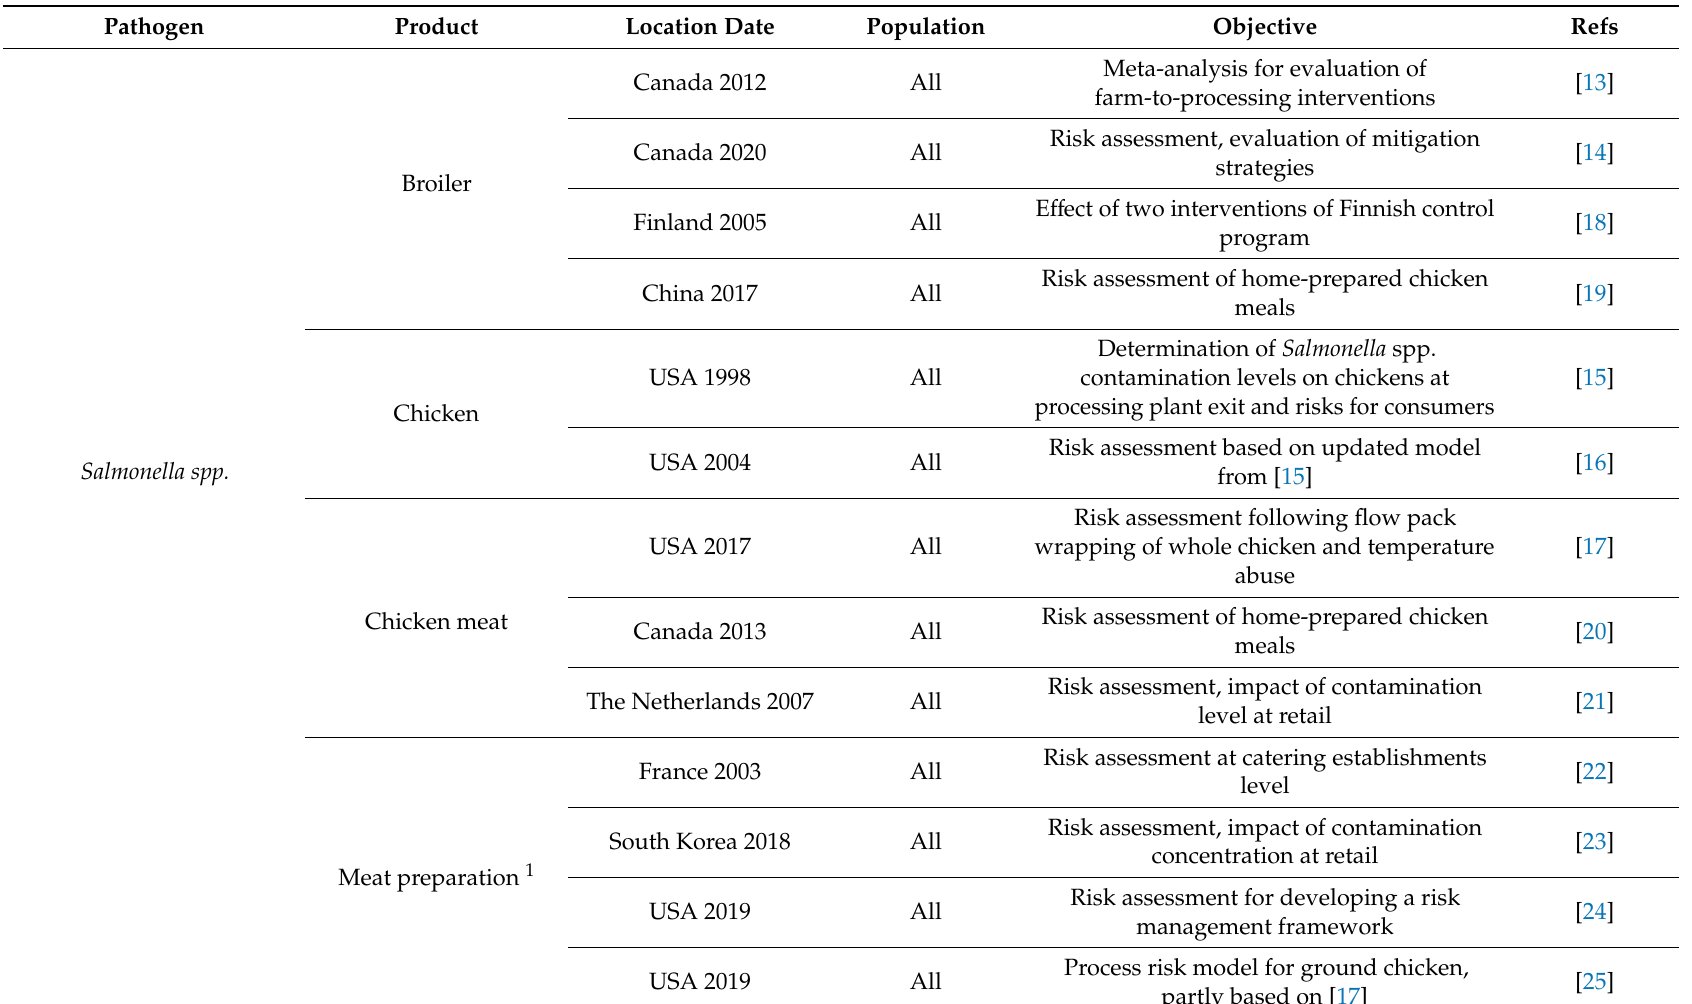
Table 1. Summary of collected poultry meat QMRA